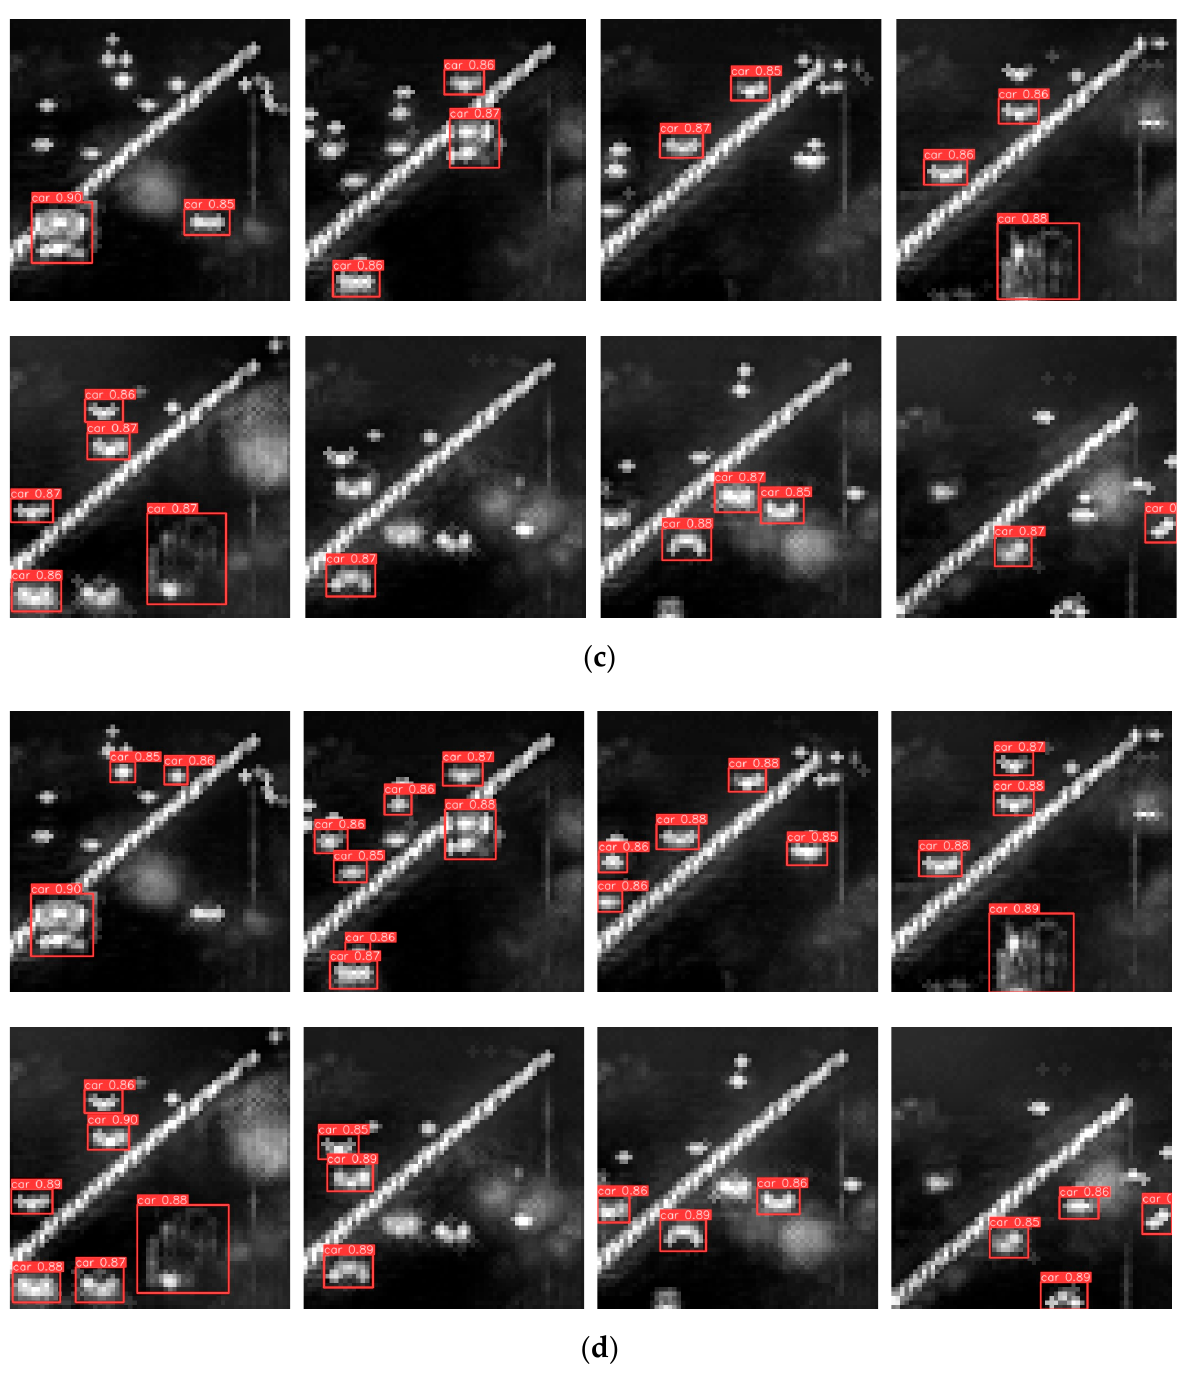
Figure 15. Detection results of different networks. ( a ) YOLOv5s detection result (conf ≥ 0.85); ( b ) YOLOv5s_Ghost detection result (conf ≥ 0.85); ( c ) YOLOv5s_ShuffleNetv2 detection result (conf ≥ 0.85); ( d ) YOLOv5s_MobileNetv3 detection result (conf ≥ 0.85).